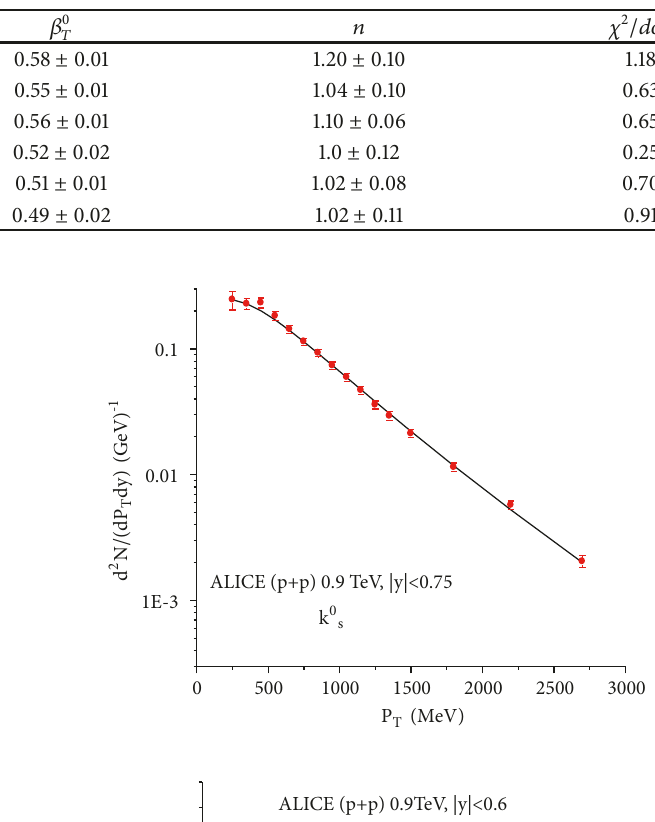
The transverse momentum spectrum of Λ is shown in Figure 5. The model curves are found to cross virtually all data points within the error bars. Also the transverse momentum distributions of (Ξ − + Ξ − ) is shown in Figure